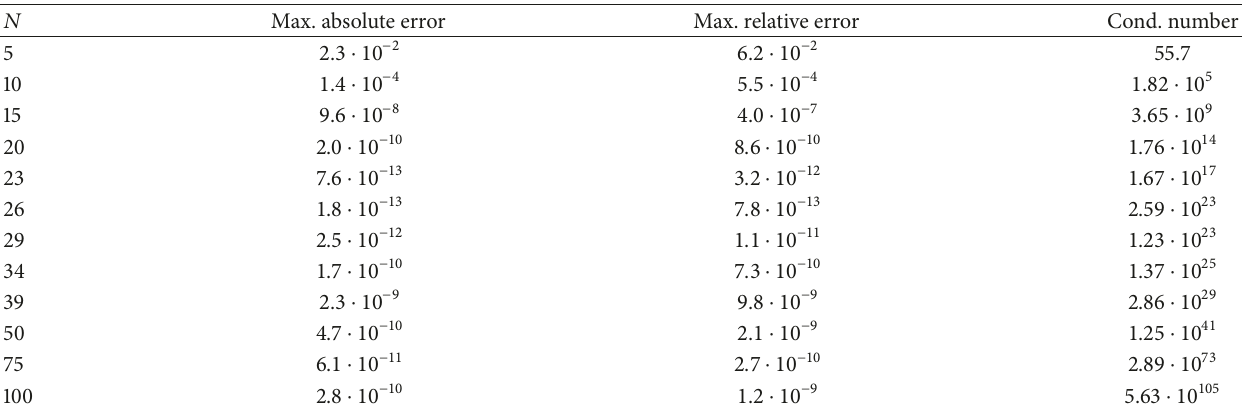
Table 1: Maximal absolute and relative errors of the approximate solution and condition number of the matrix in (30) for problem (31)–(33) obtained for different values of 𝑁 in